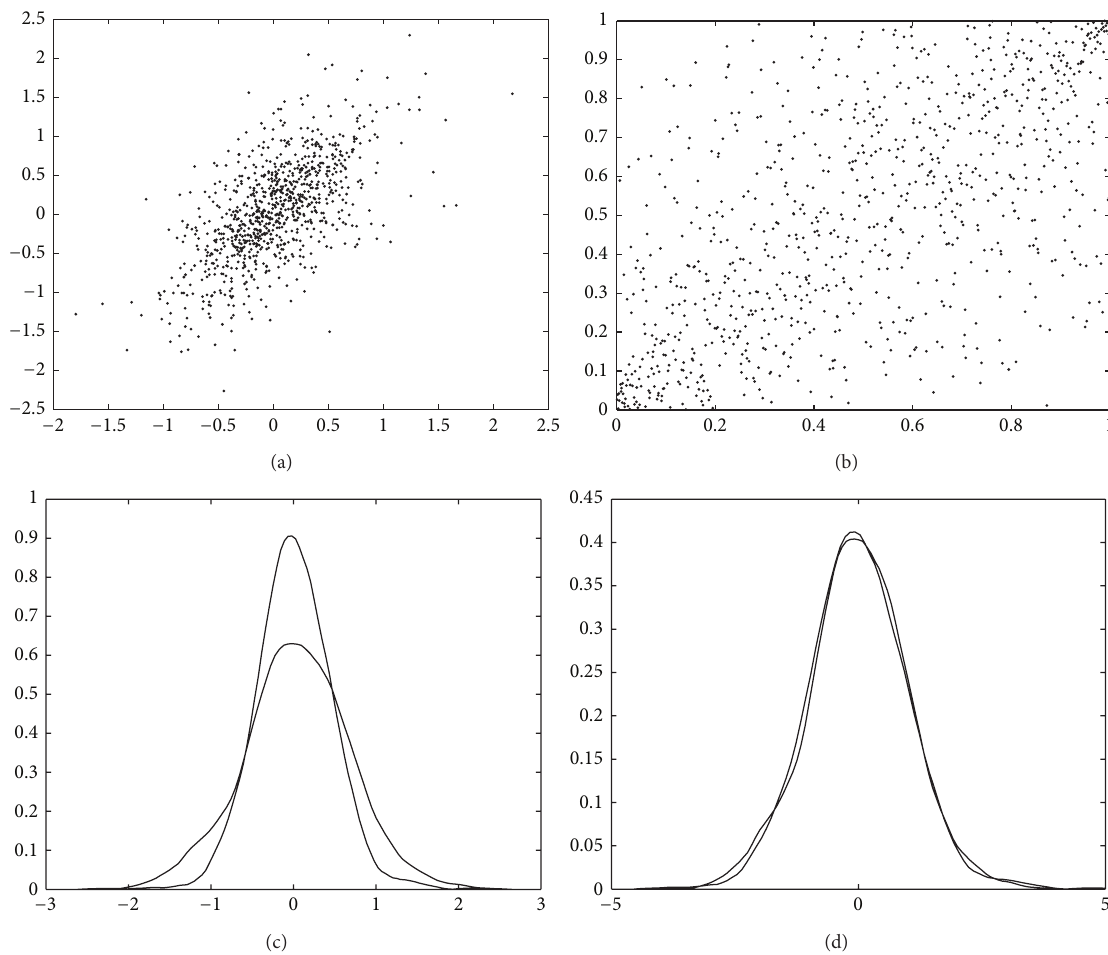
Figure 1: Last 𝑛 = 904 observations of the pair (3,4) in the Oil currency data set. (a) Scatterplot of the original data; (b) scatterplot of the standardized ranks; (c) estimated densities; (d) estimated standardized